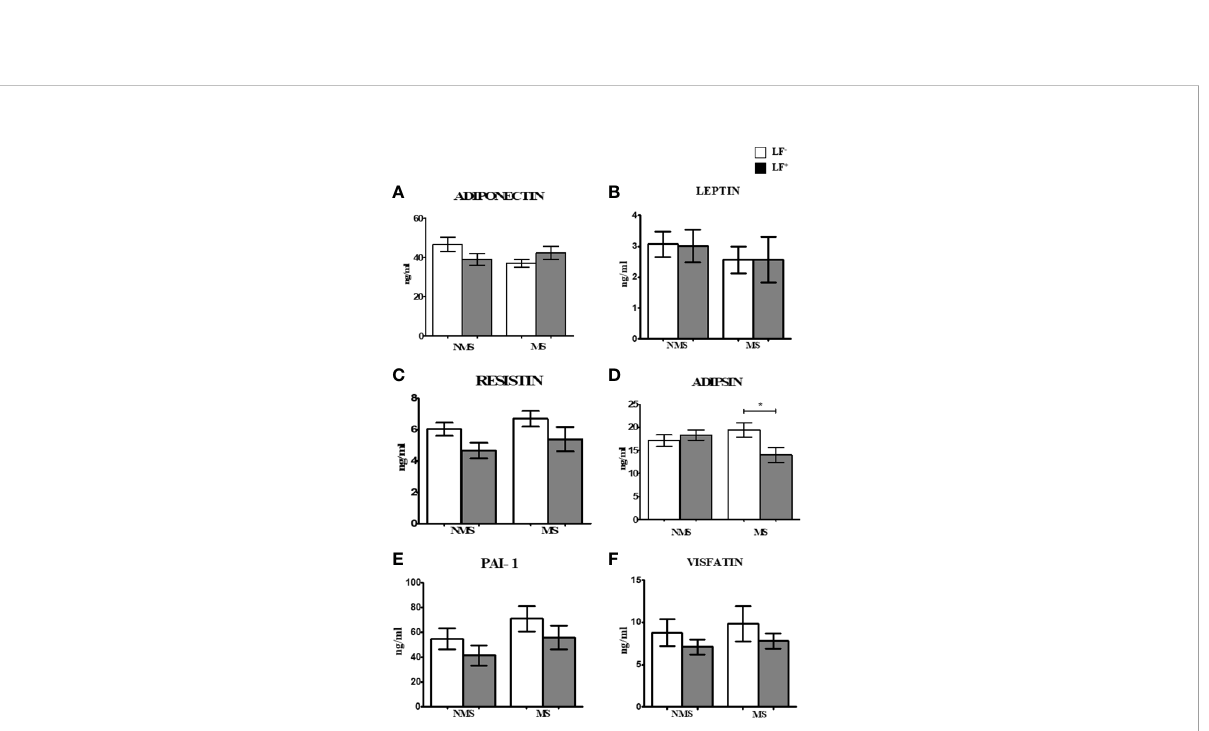
FIGURE 2 Baseline circulating levels of adipokines in MS-LF study groups. Bar with error bars represent the mean ± SD of levels of adiponectin (A) , leptin (B) , resistin (C) , adipsin (D) , PAI-1 (E) and visfatin (F) in the serum of study subjects. The levels of adiponectin and adipsin were estimated by Bio- Plex Pro Human Diabetes Adipsin and Adiponectin assay. Levels of leptin, resistin, PAI-1 and visfatin were estimated by Bio-Plex Pro Human Diabetes 10-Plex Assay. Statistical signi fi cance was determined by non- parametric Mann-Whitney U test and p<0.05 was considered signi fi cant.